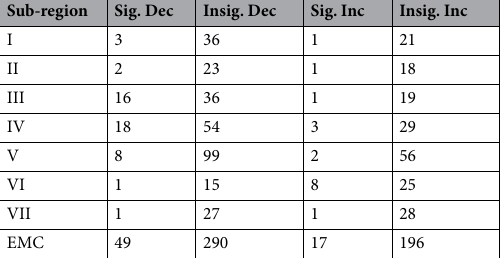
Sub-region Sig. Dec Insig. Dec Sig. Inc Insig. Inc